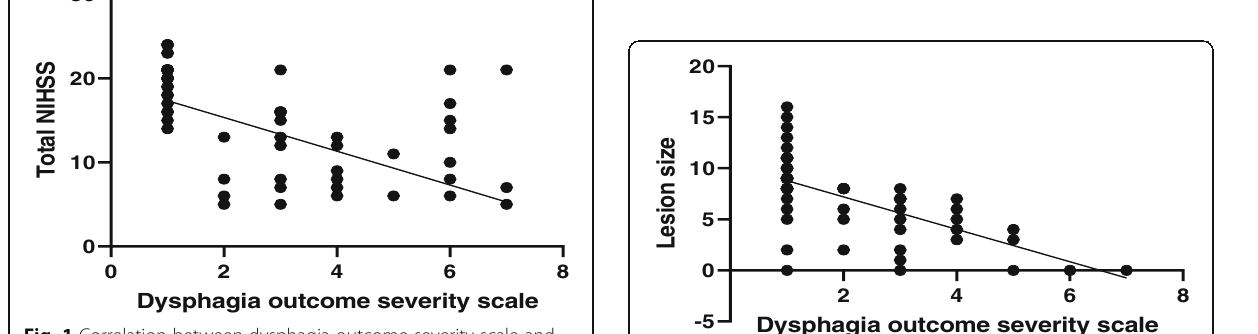
Fig. 1 Correlation between dysphagia outcome severity scale and total National Institutes of Health Stroke Scale, significant negative correlation between severity of dysphagia and NIHSS, r = 0.580 , P < 0.0001